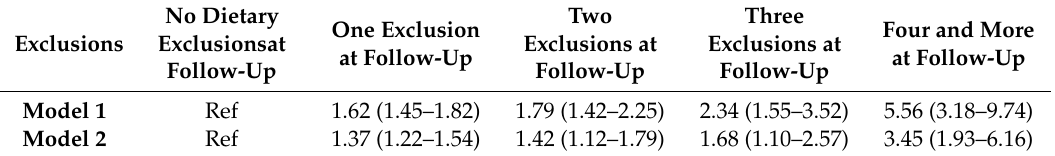
Table 4. Odds ratio and 95% CI from multinomial logistic regression of having dietary exclusions at follow-up associated to depressive symptoms at baseline (binary measure) (N = 25,356).